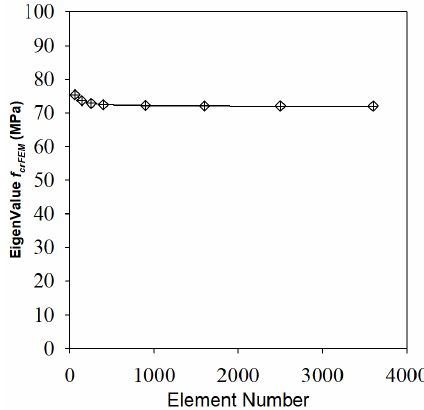
Figure 9. Finite element (FE) models converge using mesh refinement.